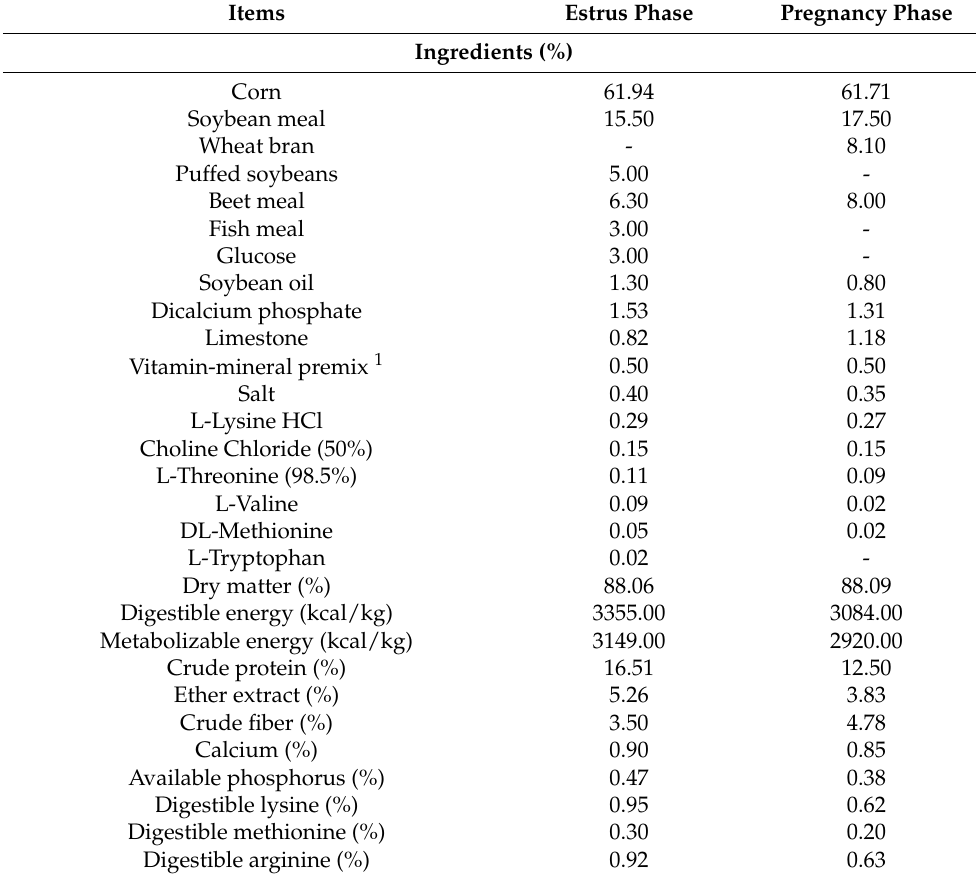
Table 2. Composition and Nutrient Composition of the Basal Diet for Sows (As-Fed